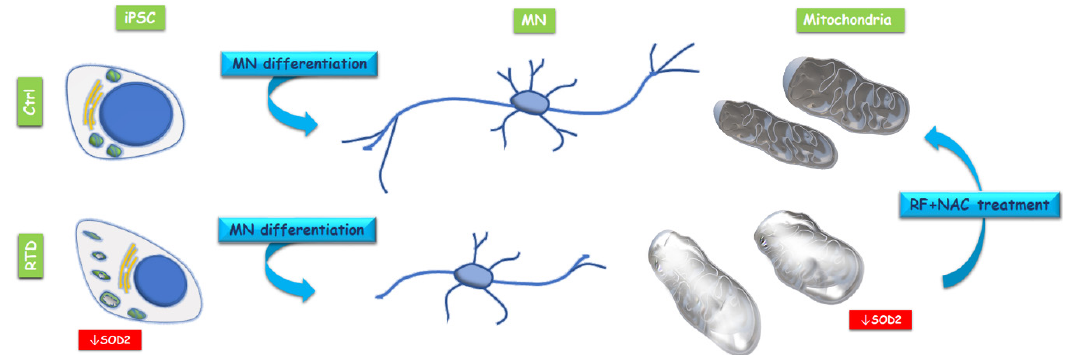
Figure 3. Conceptual schema showing mitochondrial alteration in RTD induced pluripotent stem cells (iPSCs) and iPSC derived MNs and beneficial effects of RF + NAC treatment on mitochondrial morphology.